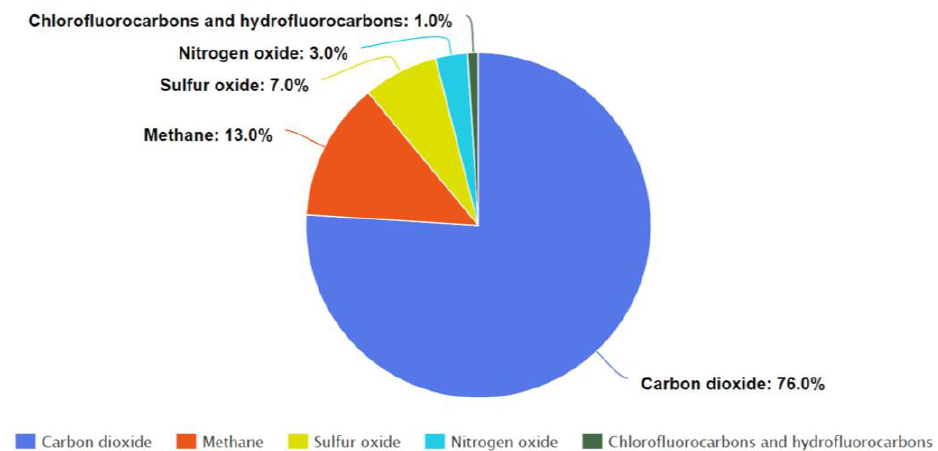
Figure 1. Greenhouse gases emission and their main sources in 2019 (based on the information from [2]).